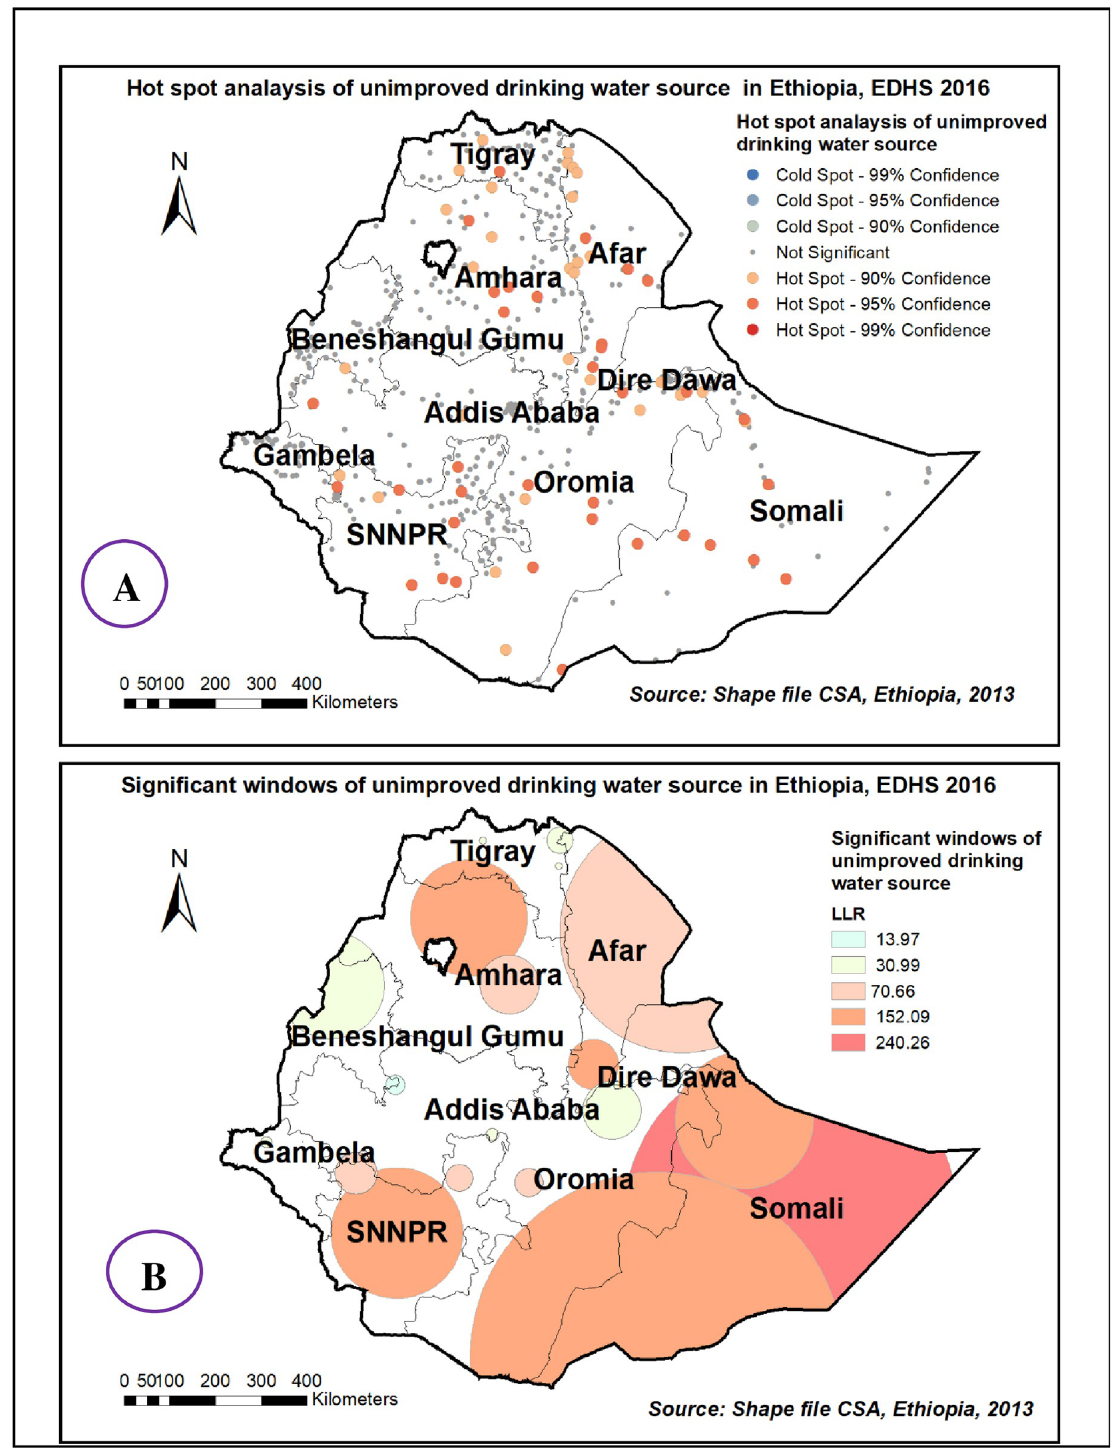
Fig 5. Hot spot areas (A) and significant windows (B) of unimproved drinking water source in Ethiopia, EDHS 2016, shapefile from 2018 GADM and plotted using ArcMap version 10.7 software.